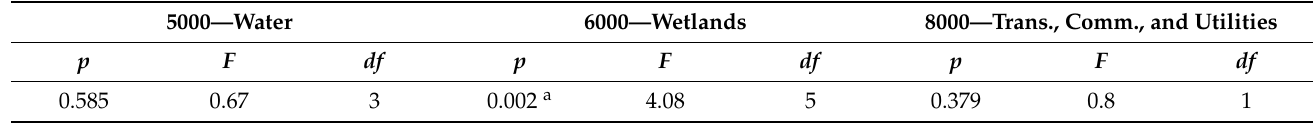
Table 5. AOV results to test for differences in plot AGTC (kg) between sub-classes for Level I “Water”, “Wetlands”, and “Transportation, Communication, and Utility” classes ( p : p -value; F : F -value; df : degrees of